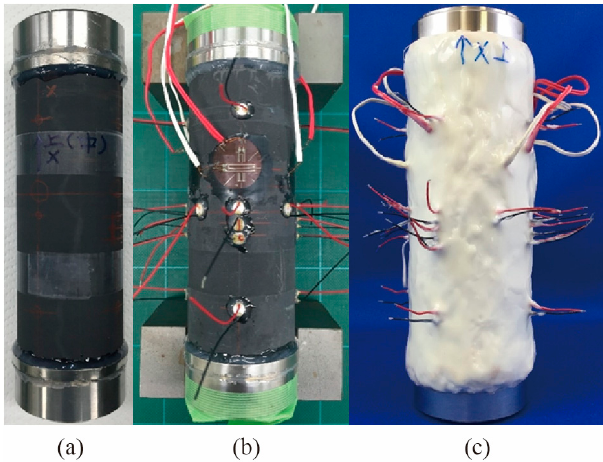
Figure 3. Preparing procedure for the shale sample before the hydraulic fracturing test. ( a ) Mount the end pieces; ( b ) Install the PZT sensors and strain gauges according to Figure 2; ( c ) Seal the sample using a silicone coat.